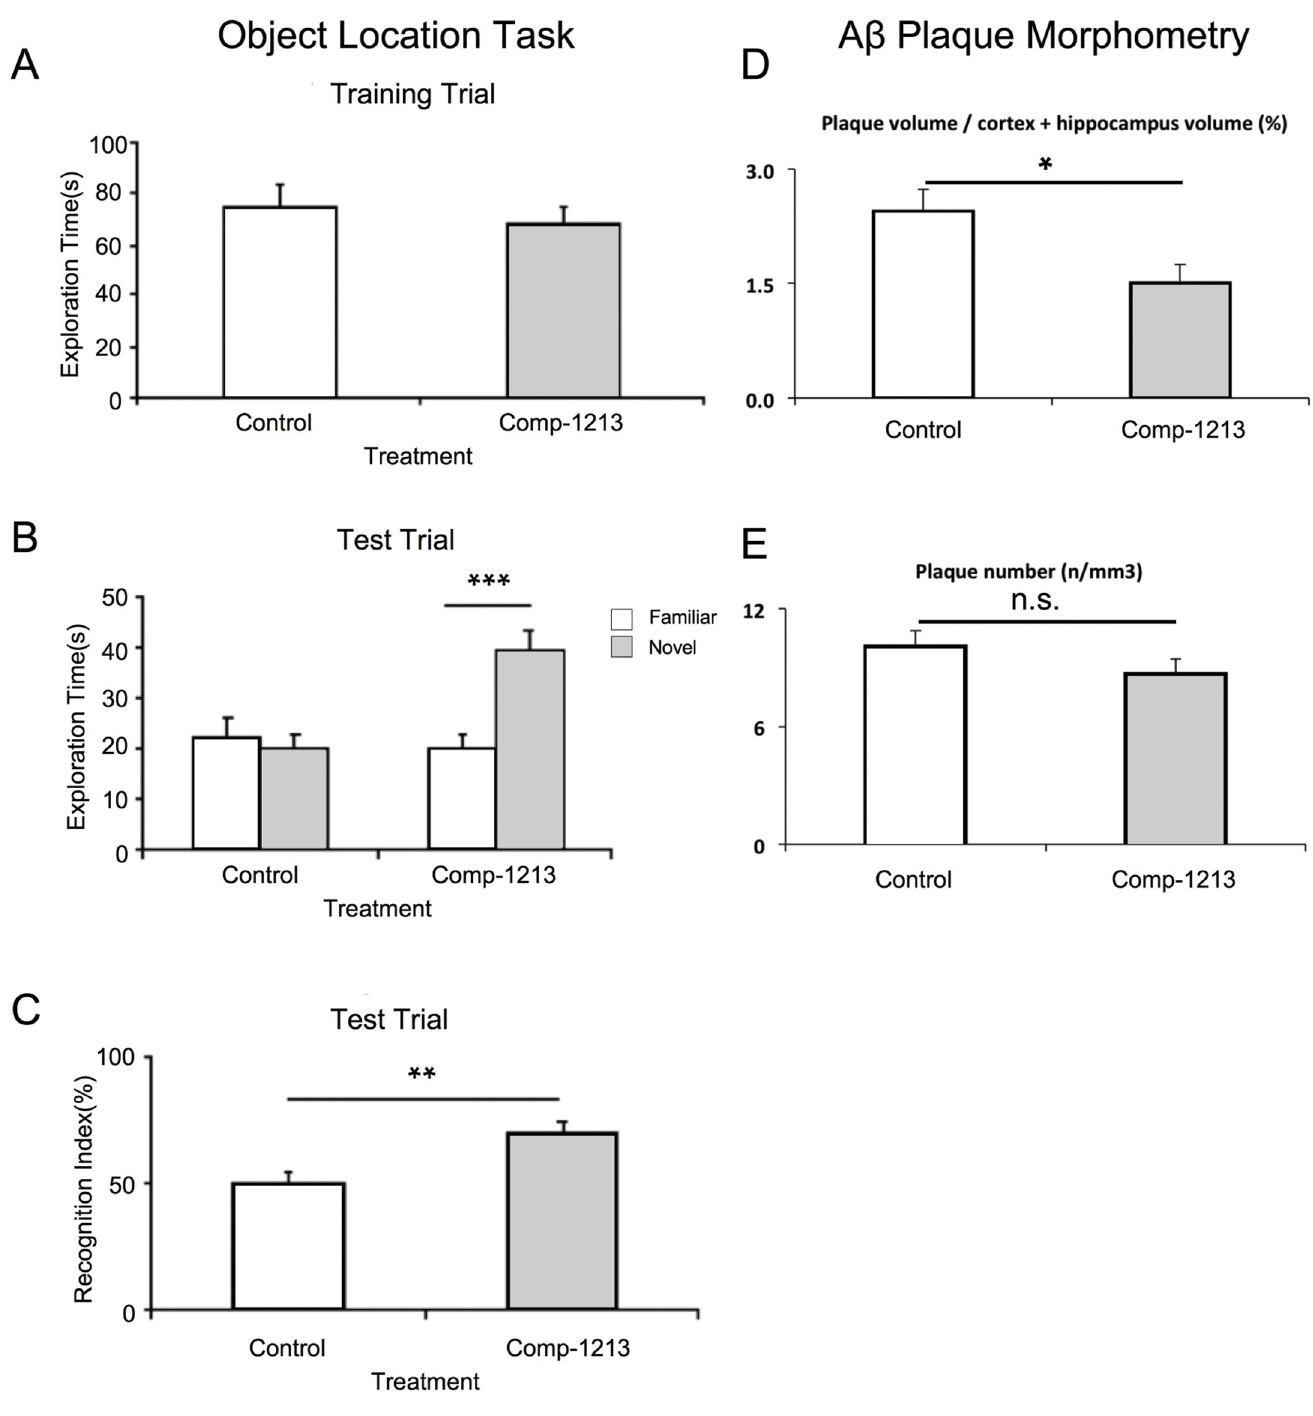
Figure 6. C1213 attenuates A β -induced cognitive deficits and reduces A β plaque volume in CRND8 transgenic mice. (A–C) An object location task was performed with Veh- and C1213-treated CRND8 mice. (A) Both treatment groups showed equivalent object explo- ration times in the test trial. (B) C1213-treated mice displayed preferential examination of the object moved to a novel location and (C) a significantly enhanced recognition index. (D–E) Immunohistochemical analysis of A β plaques in CRND8 mice. (D) Treatment with C1213 significantly reduced A β plaque volume while (E) plaque number remained unchanged. * P < 0.05; ** P < 0.01; *** P < 0.001. n.s., not